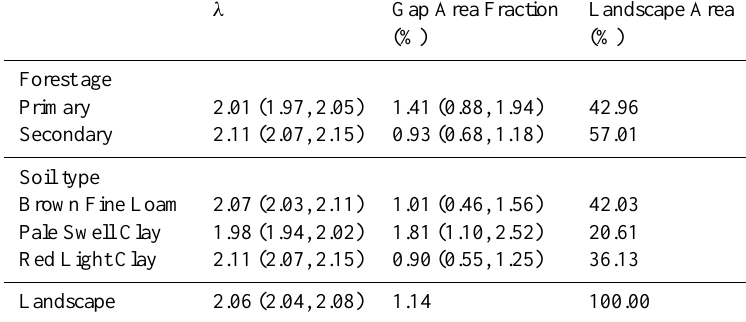
Table 2. Effect of forest age and soil type on the gap size distribution ( λ ), and the percent of plot area in gaps (Gap Area Fraction). Means and standard errors are calculated using MLE for λ and sub-sampling method for the gap area fraction. The confidence interval of λ appears in parentheses next to the mean. The percent of the landscape represented by each category appears is shown in last column. The landscape category comprises the entire island, excluding the shores and the laboratory clearing, with an area of 1484ha.